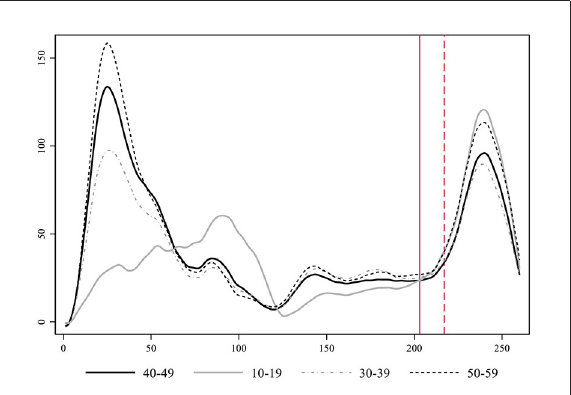
FIGURE7 Evolution of the rate of COVID-19 cases per day in Catalonia by age-group with data corrected by the level of